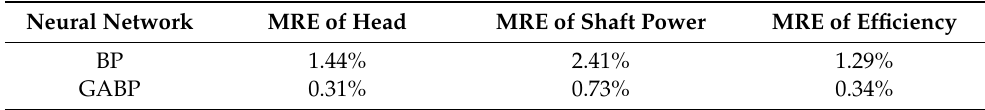
Table 10. Comparison of the MRE of the prediction. Neural Network MRE of Head MRE of Shaft Power MRE of